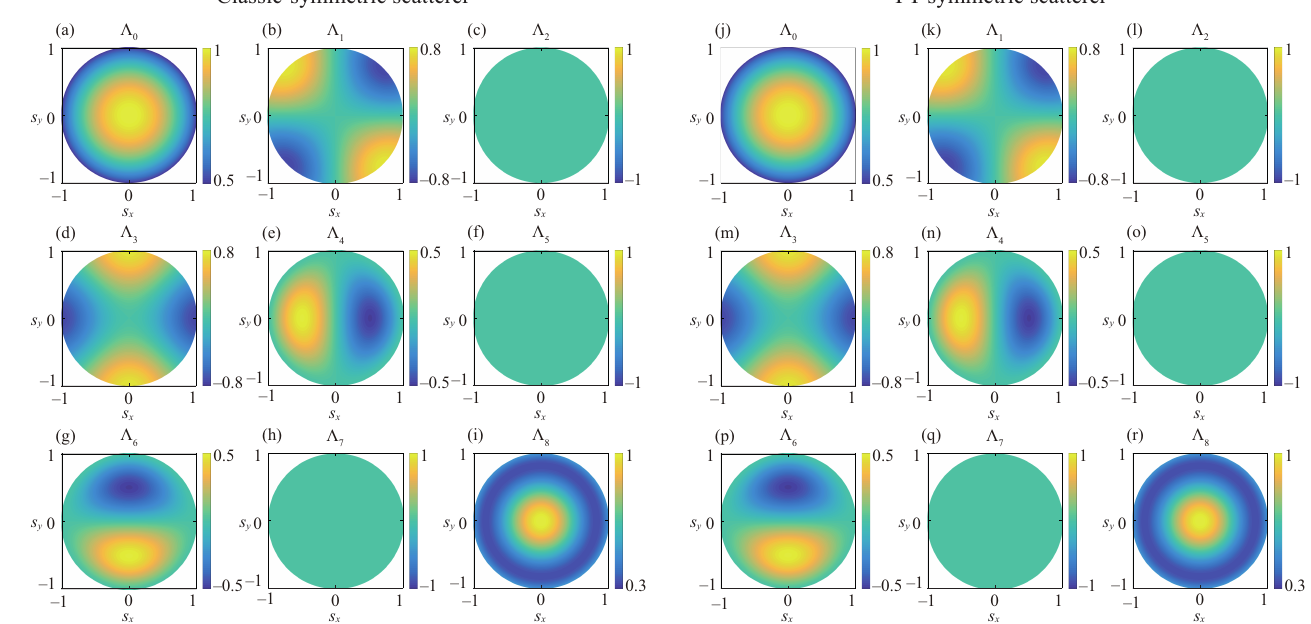
Figure 4. Simulation results for the nine generalized Stokes parameters of the far-zone scattered field by a four-point scatterer having ( a – i ) classic-symmetric potential and ( j – r ) PT-symmetric potential. The incident beam is a partially coherent radially polarized beam with the GSM correlation function. The spatial coherence width ξ 0 = 0.2/ k